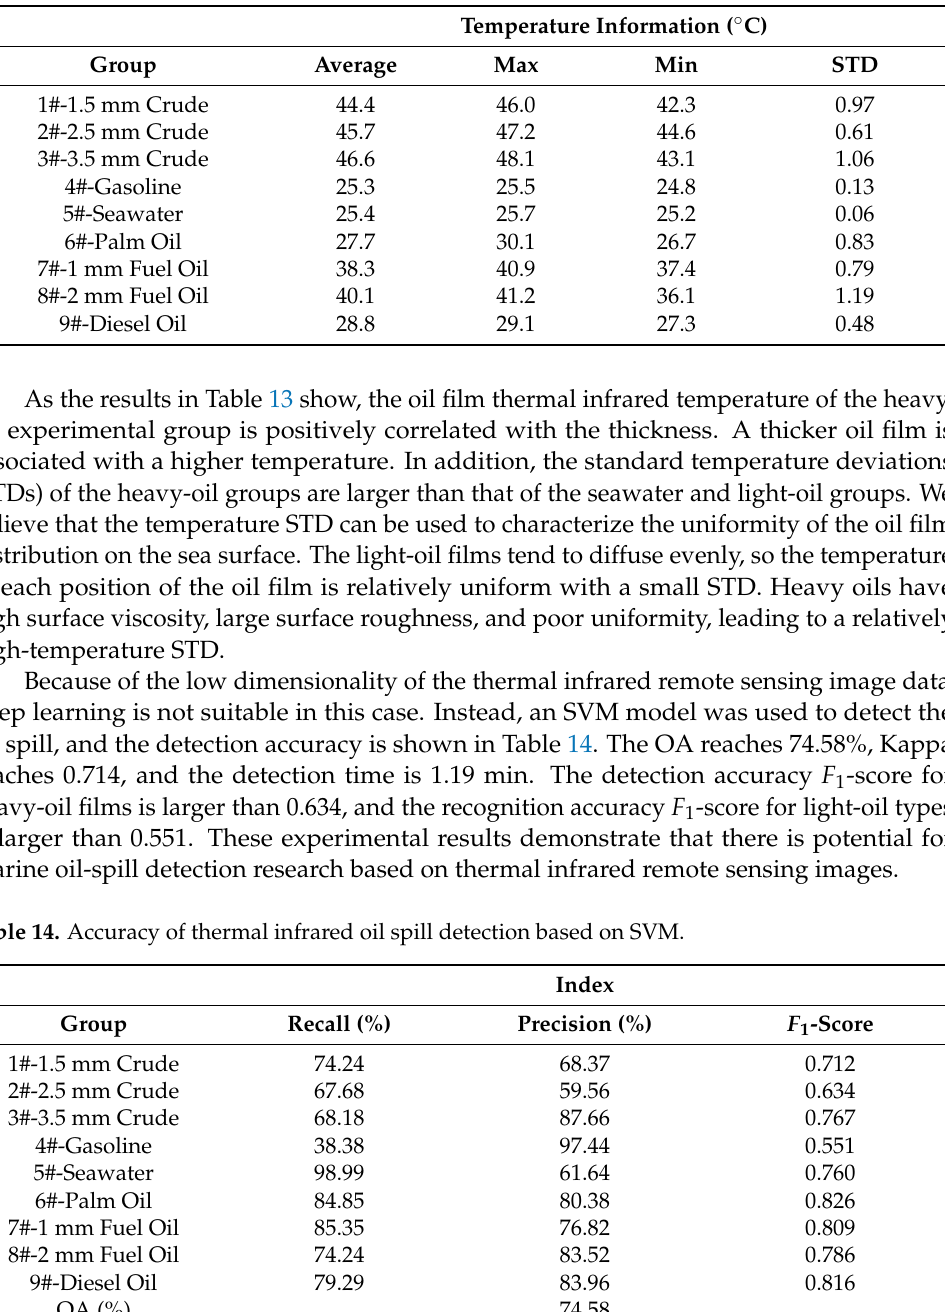
Table 13. Thermal infrared temperature data of oil spill at T1.